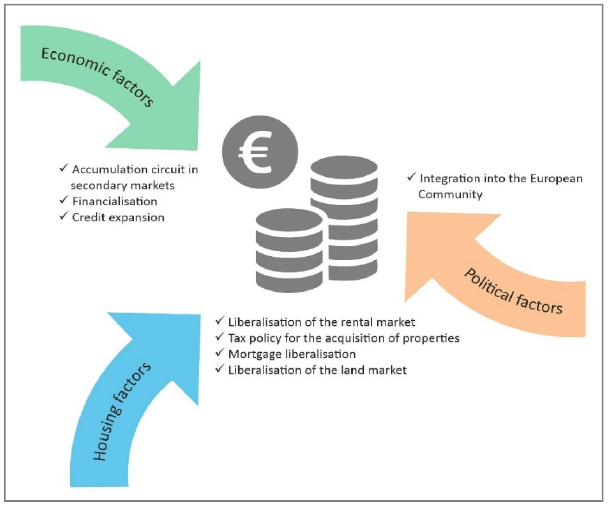
Figure 2 . Factors conditioning the economic housing expansion in Spain (1998–2008). Source: au- thor’s